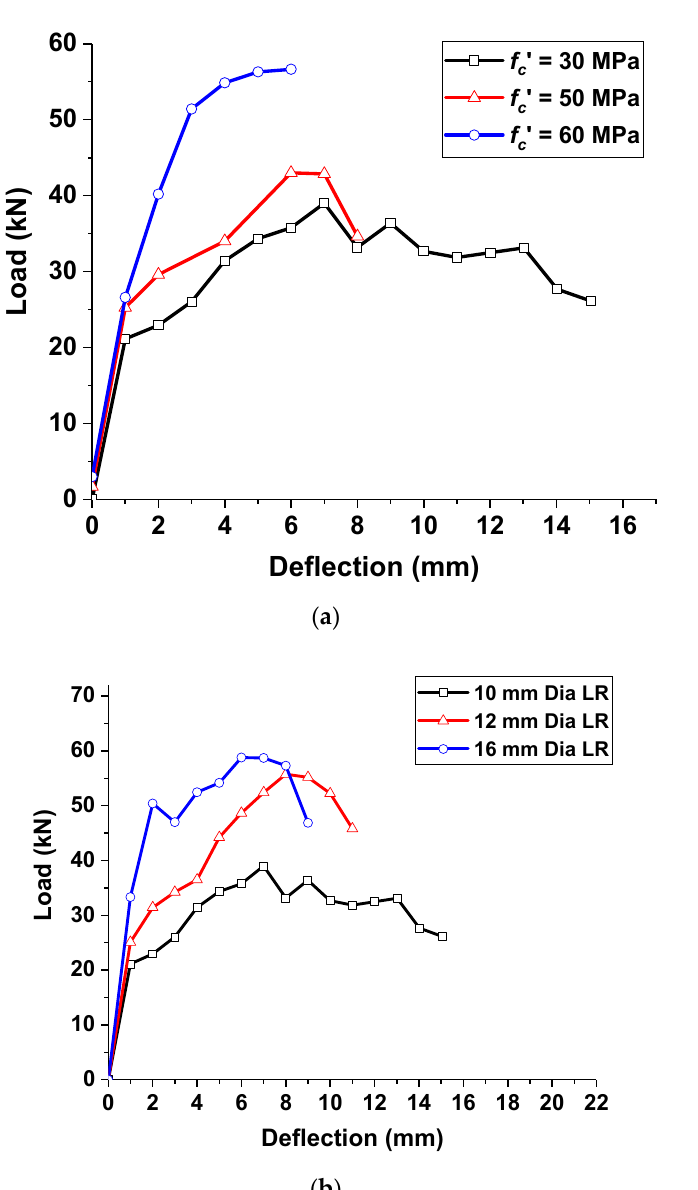
Figure 11. Parametric studies on the effect of strength and longitudinal reinforcement ratio: ( a ) effect of concrete strength and ( b ) effect of longitudinal reinforcement ratio.